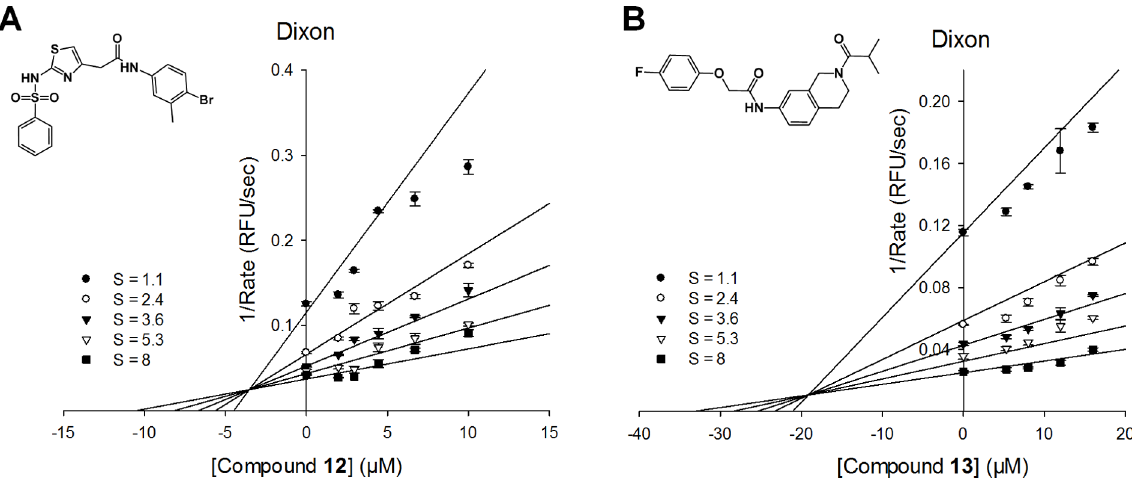
Figure 3. Mechanism of enzyme inhibition of 12 and 13. Dixon plot for competitive inhibition of Compound 12 ( A ) and Compound 13 ( B ) with respect to the substrate Ac-DE-Dap(QXL520)-EE-Abu- y -[COO]AS-C(5-FAMsp)-NH 2 . Determined K i values of Compound 12 and 13 were 3.5 m M and 19.1 m M, respectively. A known competitive inhibitor BILN-2061 was used as a control. Four equations (See Experimental section) in SigmaPlot Enzyme Kinetics Module 1.3 were used to fit the experimental data. The competitive inhibition model was the best fit for both compounds and for the control.